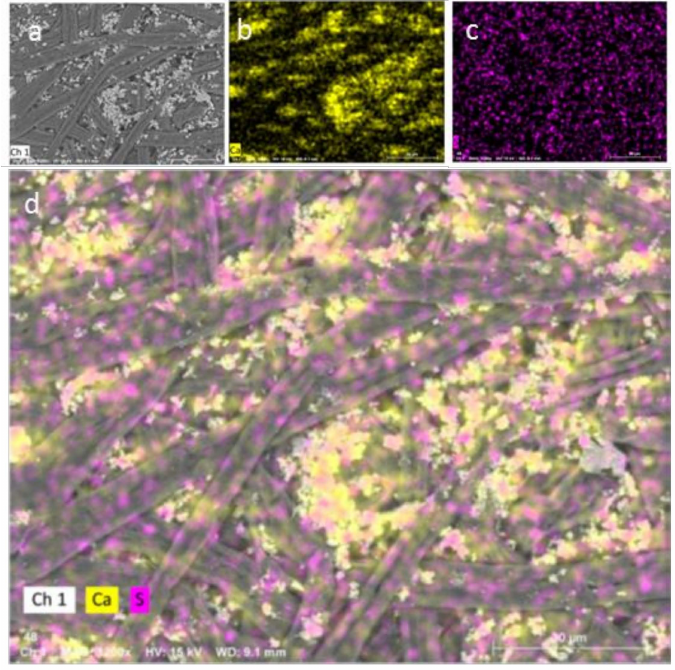
Figure 9. SEM ( a ) and SEM/EDS images ( b – d ) of the paper surface coated with LS. The mapping images show the distribution of Ca from CaCO 3 (( b ), yellow color), S from LS (( c ), violet color) and the combined image of Ca and S distribution ( d